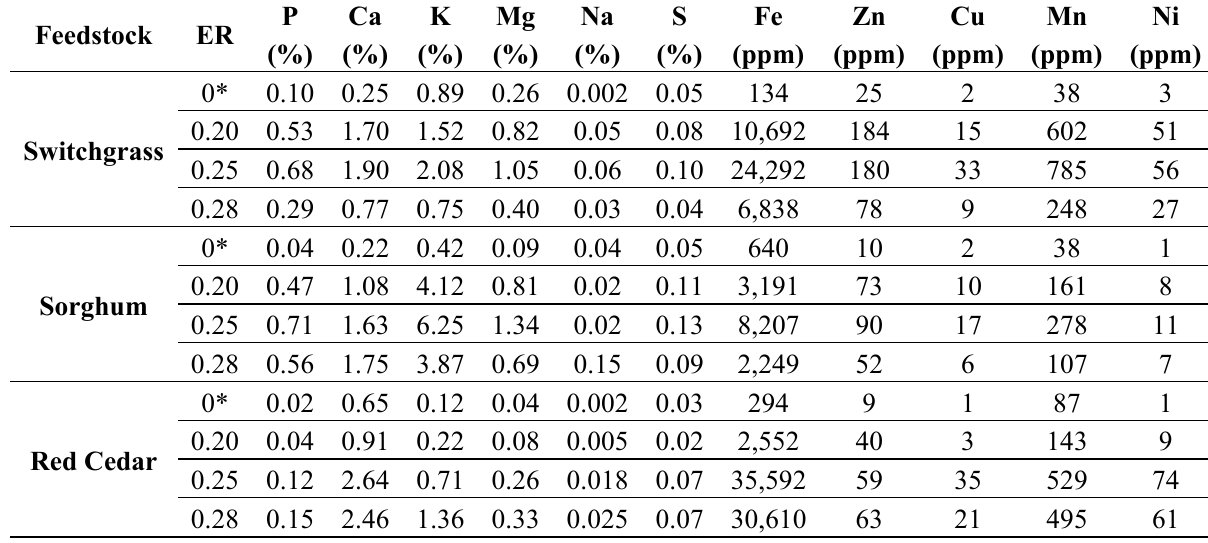
Table 4. Mineral content of